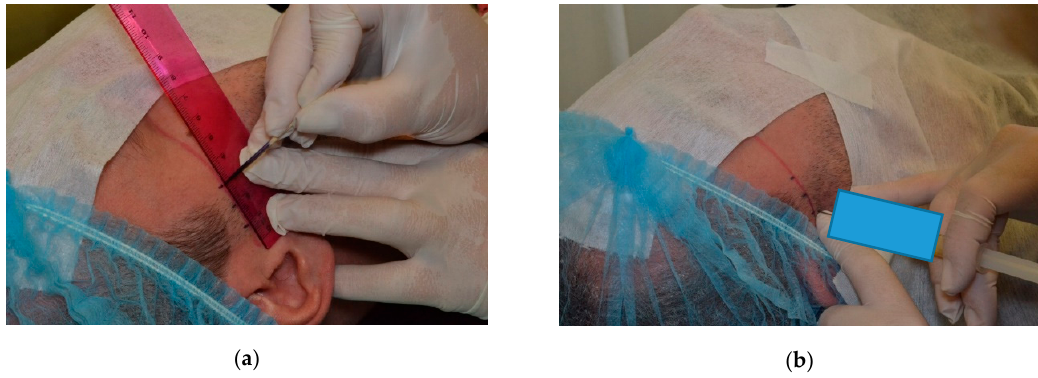
Figure 3. The assignation of the point of intra articular injection ( a ) the lines marked every 10 mm, ( b ) the injection was made at the end of 3 mm long line, started from the first marked line.